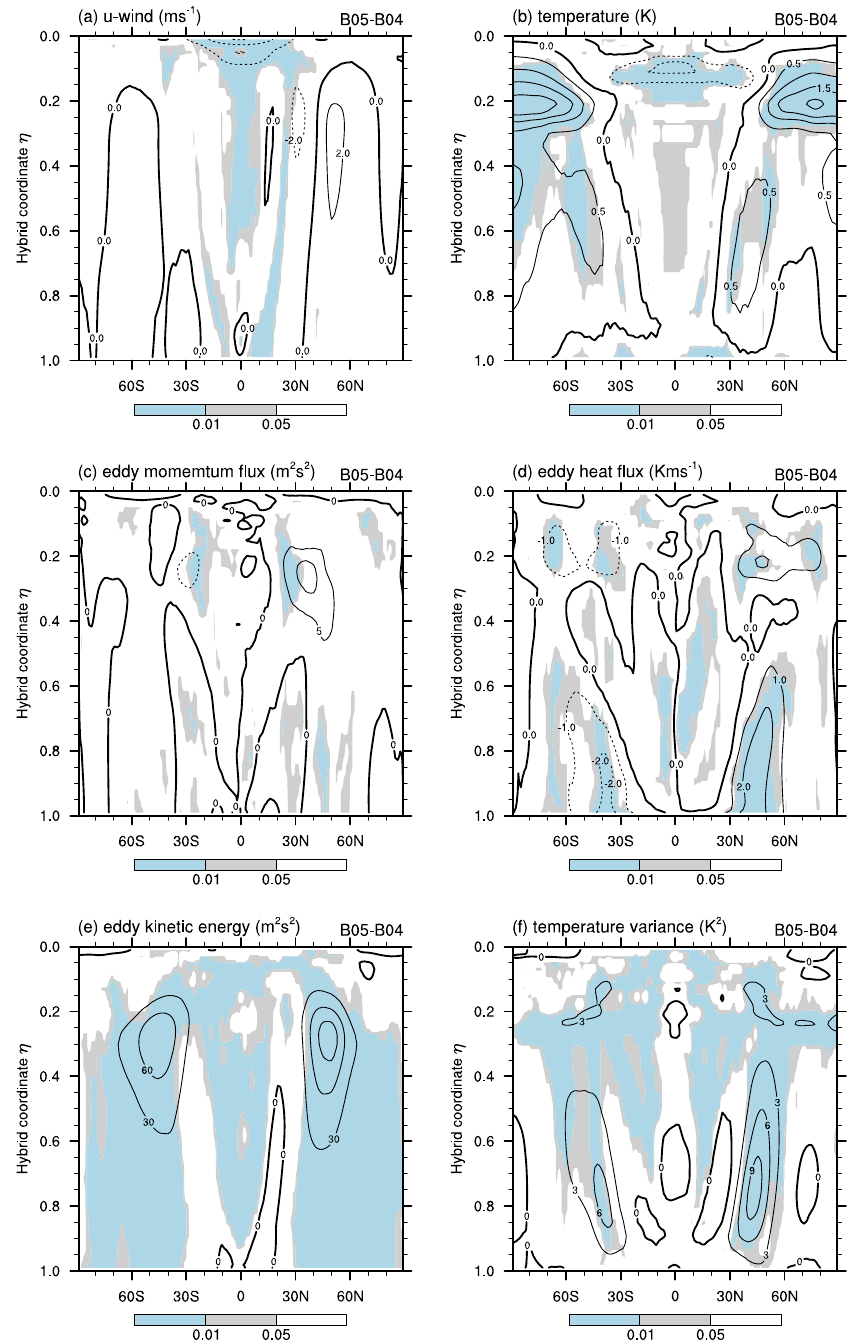
Fig. 13. As in Fig. 12 but for the differences between R2B4 and R2B5